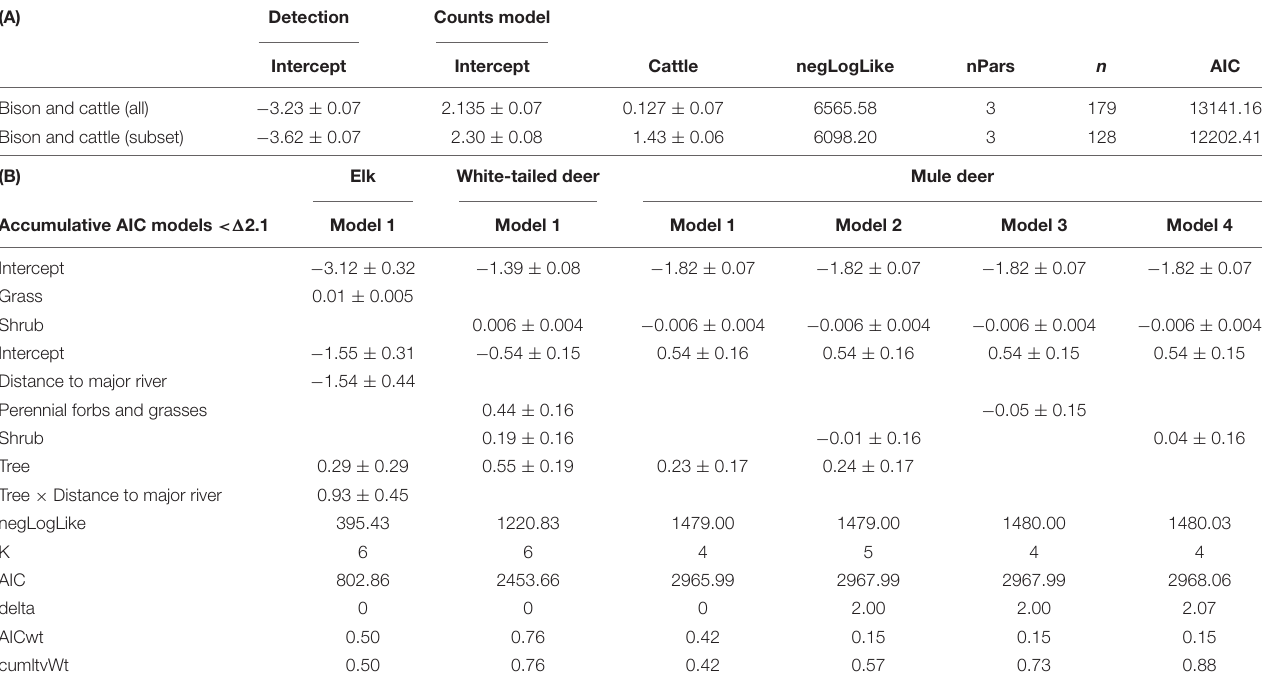
TABLE 1 | (A) Bison and cattle count model including the full dataset (all) and a subset that only includes deployments when cattle were active. (B) Occupancy estimation for deer species in relation to vegetation cover within a 100 m buffer around a camera and distance to major rivers. (A)